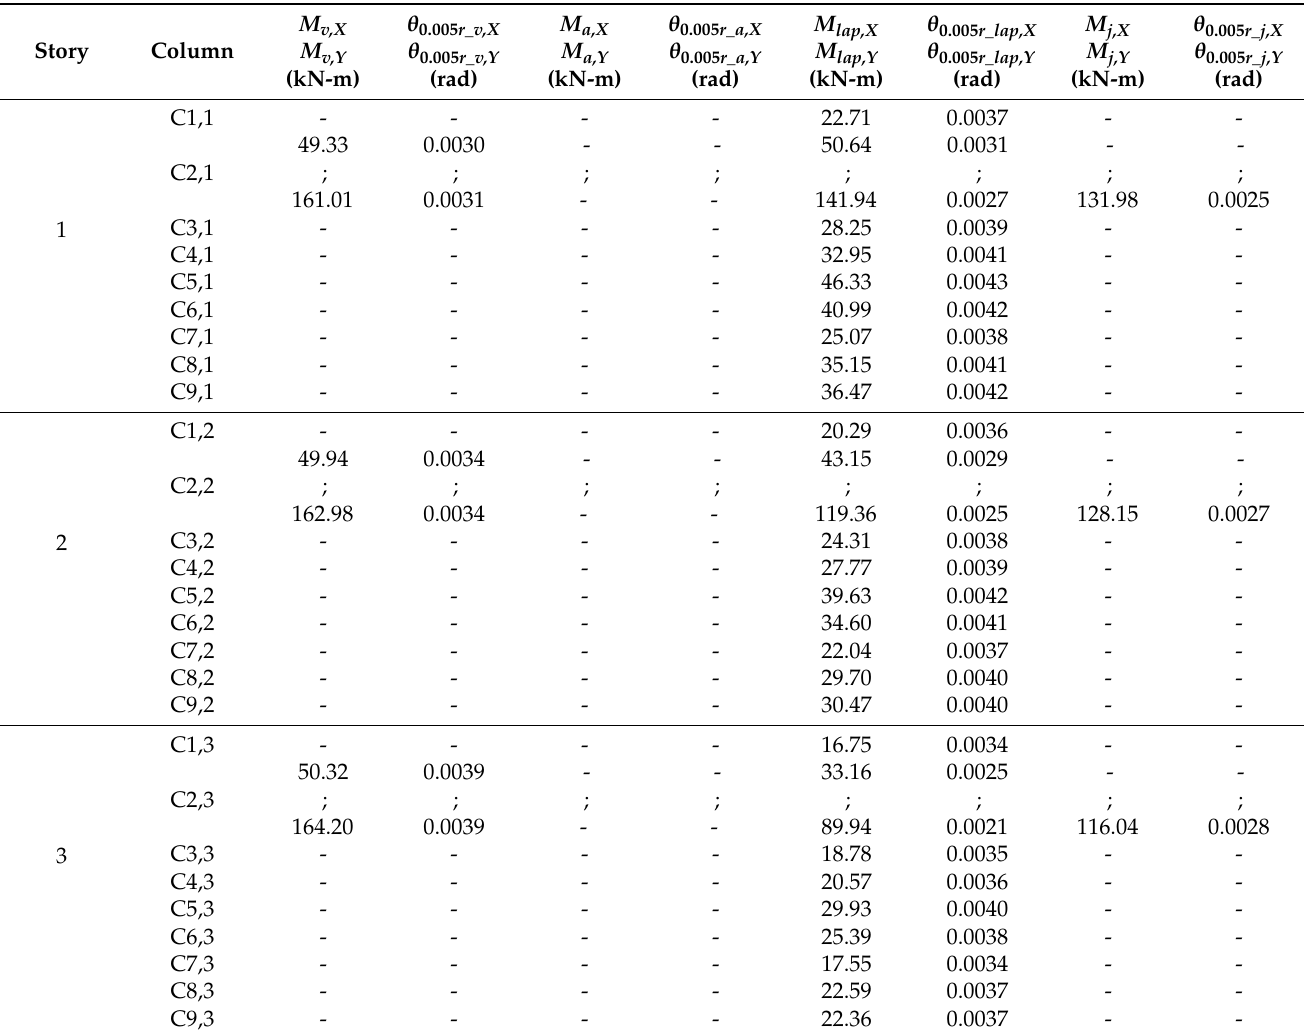
Table 2. Moment-Rotation relationships used in the zero-length elements of the SPEAR FE building model. Note: Symbols (-) indicate that brittle fracture was not considered and (;) separate values between the X and Y